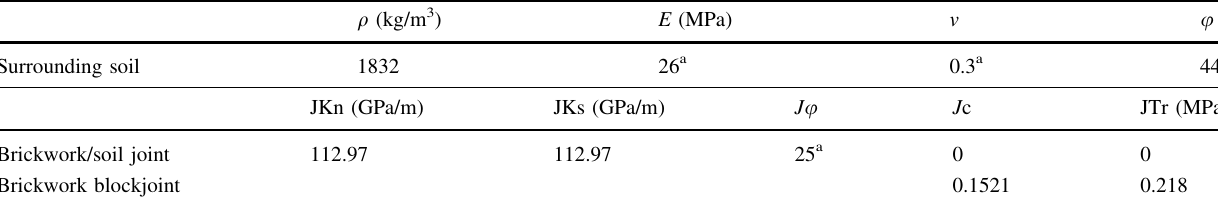
Table 5 Surrounding soil, brickwork/soil joint and brickwork block joint properties